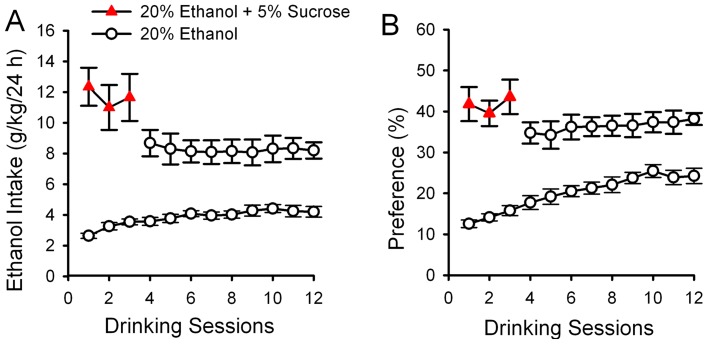
Sucrose induction induced excessive ethanol consumption and high preference in male Sprague-Dawley (SD) rats.The mean (± S.E.M) of ethanol intake (g/kg/24 h) (A) and of ethanol preference (B) in rats under the intermittent access drinking procedure with 5% sucrose in the first three drinking sessions were much higher than those in rats under the same drinking procedure without sucrose induction (all p<0.001). Two-way RM ANOVA followed by Tukey post hoc analysis, n = 11 animals for 20% +5% sucrose; n = 22 animals for 20% ethanol.